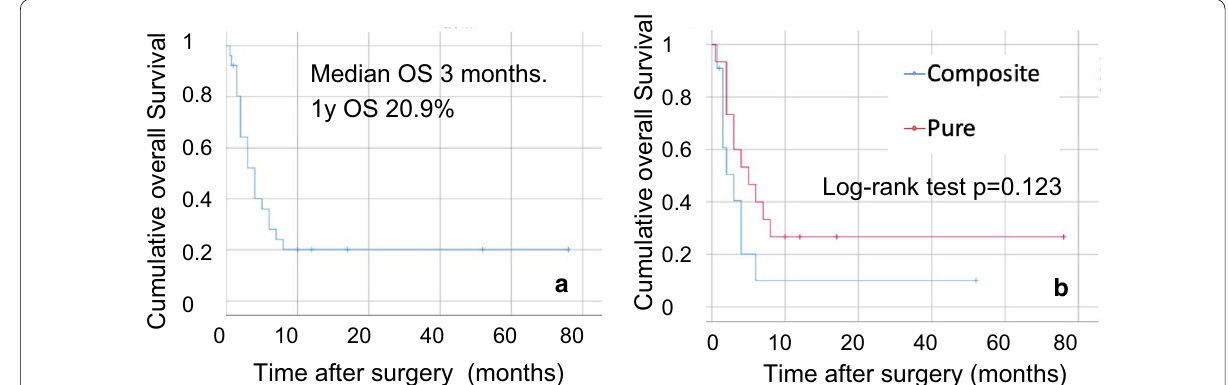
Fig. 6 Kaplan–Meier survival analyses. ( a ) Overall survival (OS) of all patients with colorectal undifferentiated carcinoma with rhabdoid features was 3 months after surgery. The 1-year survival rate was 20.9%. ( b ) Comparison of patients with the pure and composite types showed no significant difference ( p =